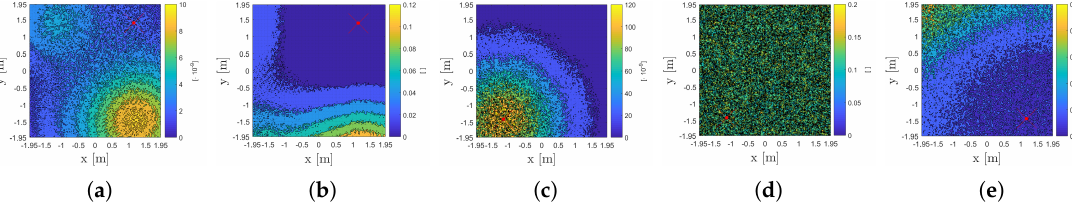
AVG = 10 segments’ t , i · R P ( 0 )) of the b ) VLP, for uVLP PD , i is also shown for (